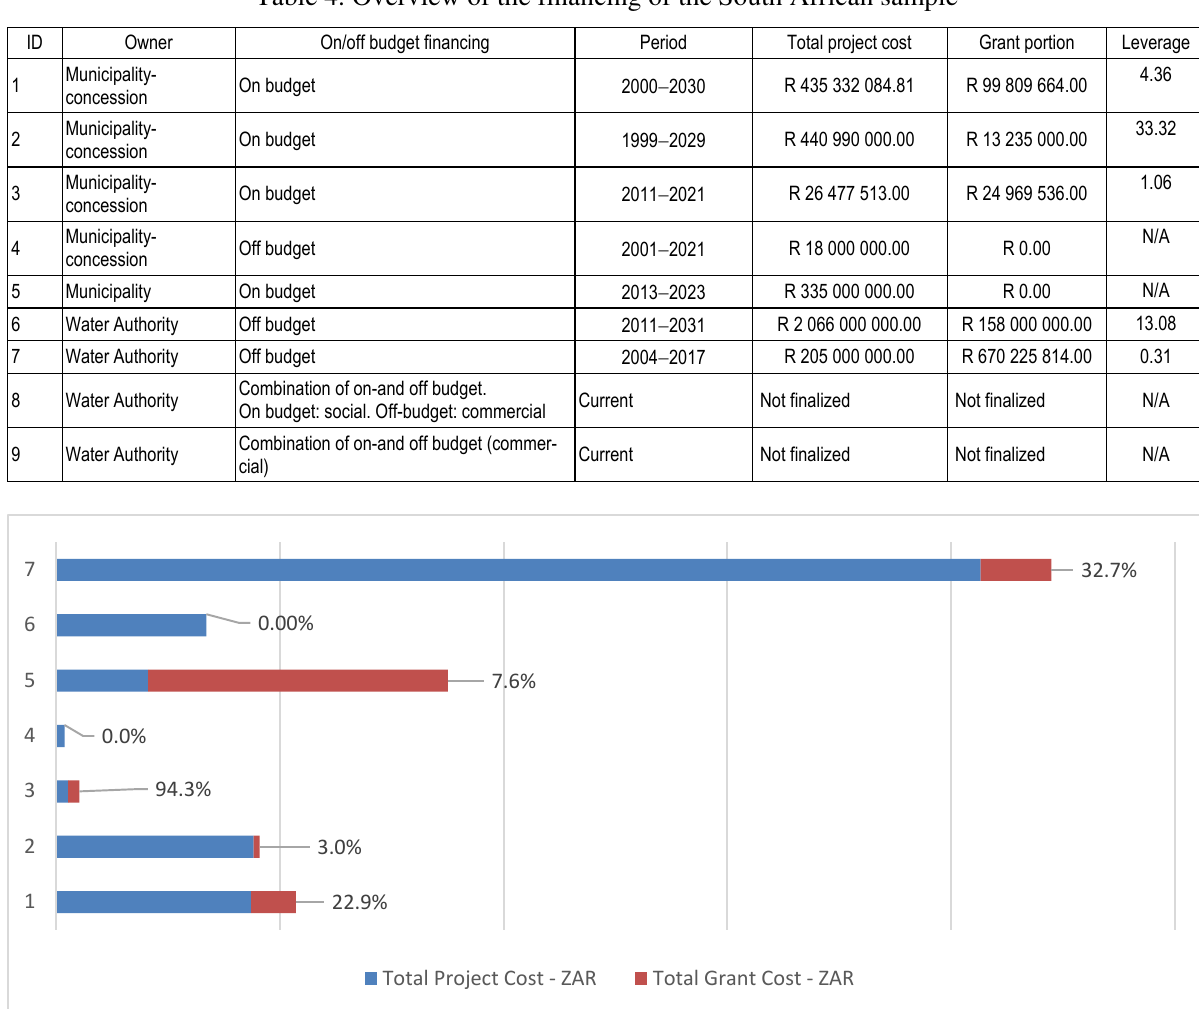
Table 4. Overview of the financing of the South African sample